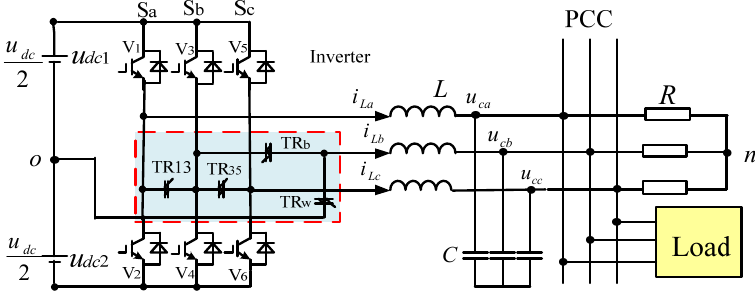
Figure 1. The topology structure of the proposed secondary reconfigurable inverter.